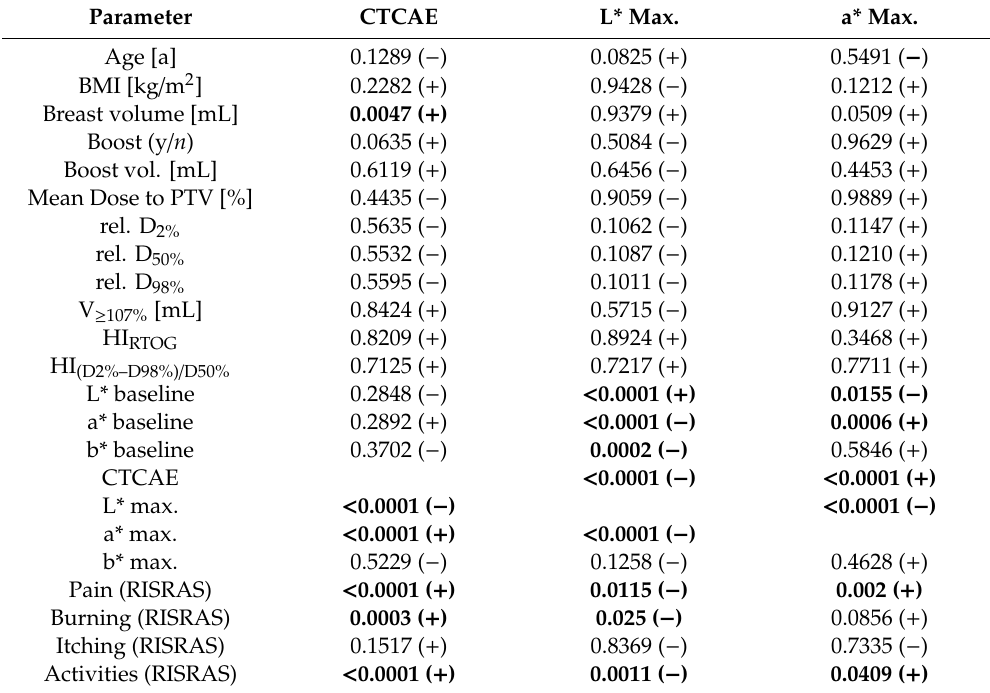
Table 3. Correlation analyses for multiple parameters in accordance to CTCAE score, maximum L* value and maximum a* value. Values indicate p -values for the slope deviances of respective linear regressions, a + or − (in brackets) indicates whether the regression was positive or negative. Values in bold indicate statistically significant di ff erences ( p <